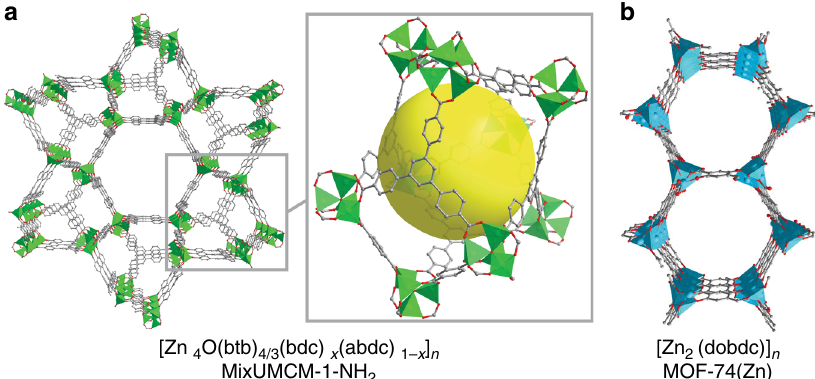
Fig. 2 Structures and molecular formulas of the MOFs used in hydroformylation. a MixUMCM-1-NH 2 . b MOF-74(Zn). bdc = 1,4-benzenedicarboxylate; abdc = 2-amino-1,4-benzenedicarboxylate, btb = 4,4 ′ ,4 ′′ ,-benzene-1,3,5-triyl-trisbenzoate and dobdc = 2,5-dioxido-1,4-benzenedicarboxylate. Hydrogen and nitrogen atoms are omitted for clarity.